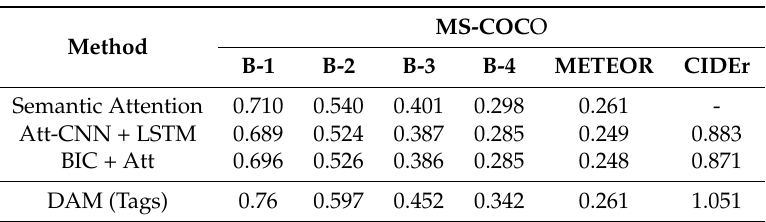
Table 2. Comparisons with attribute-based image captioning methods. All methods apply man-made user tags for fair comparisons.